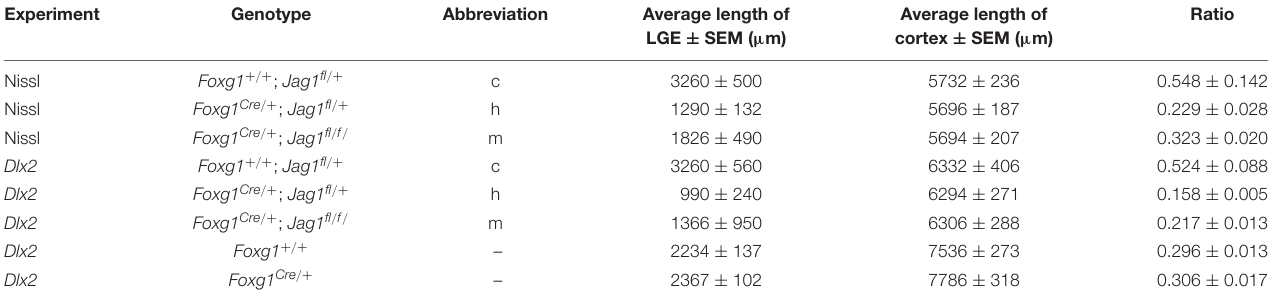
TABLE 3 | Summary of mean values for LGE and cortex